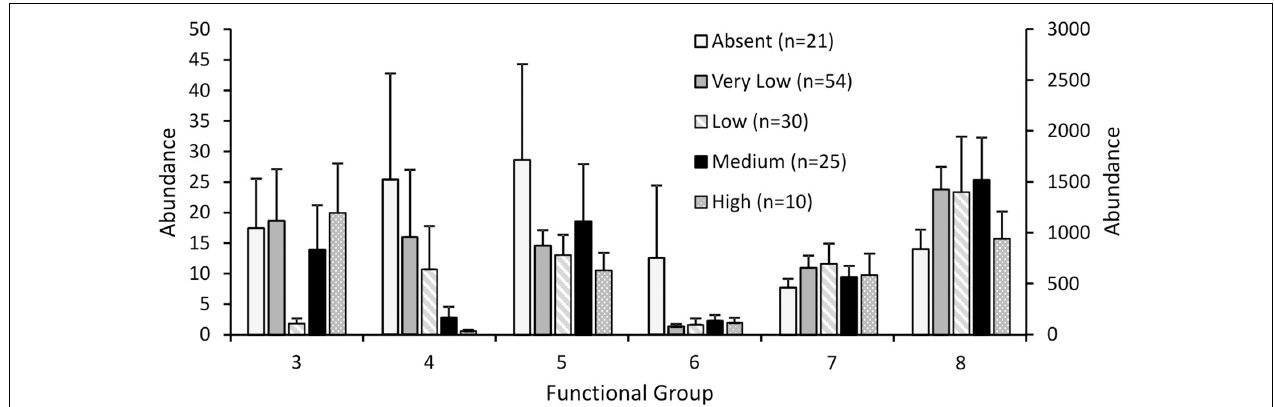
FIGURE 2 | Abundance of each functional group for the Ocean Survey 20/20 offshore dataset for different fishing effort classes. Abundance values for groups 4 and 6 are plotted on the secondary y axis. Error bars represent one standard error.